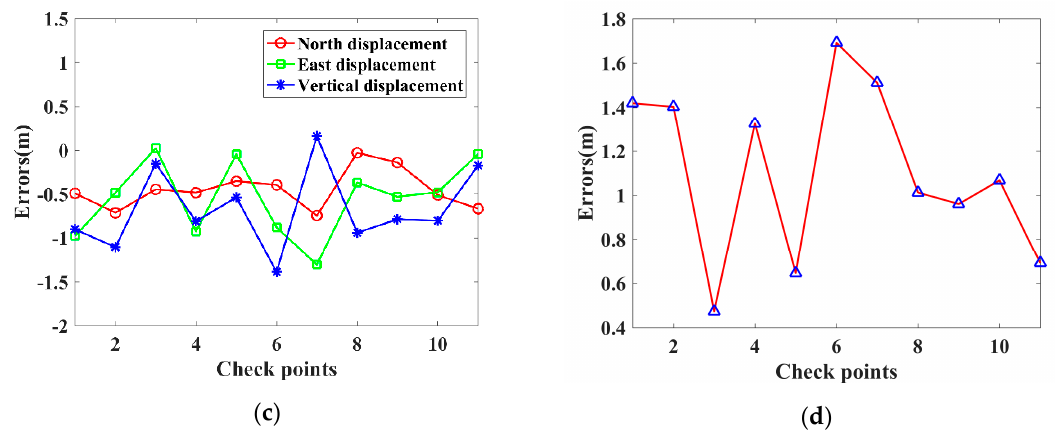
Figure 10. The geolocation errors for the street lights and street barriers located on Xingshikou Road in Beijing with two methods. ( a , c ) are the geolocation errors in the north, east and vertical displacements for M1 and M2, respectively. ( b , d ) are the three-dimensional errors for M1 and M2, respectively.